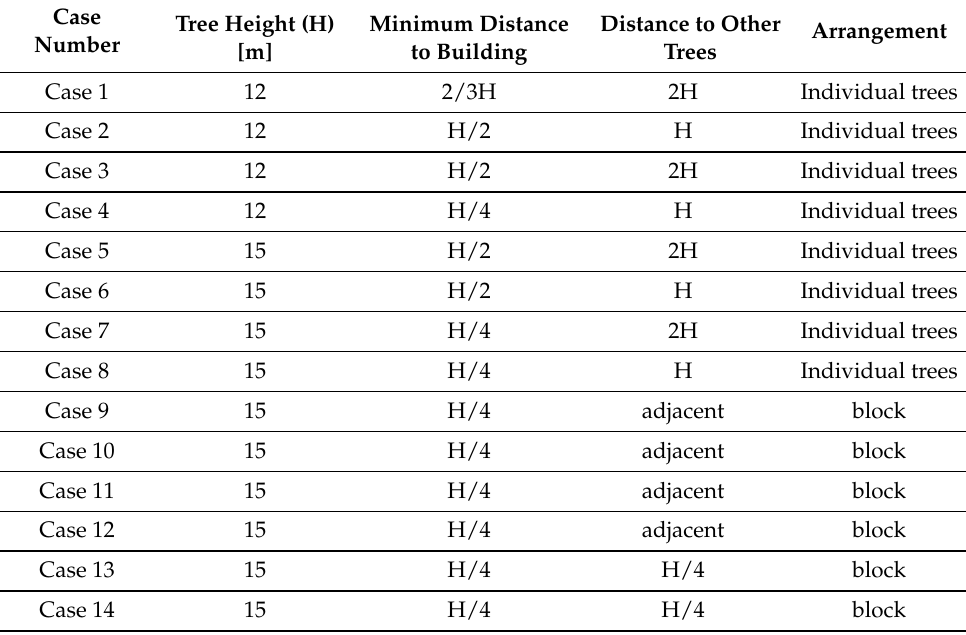
Table 4. Description of different tree arrangements